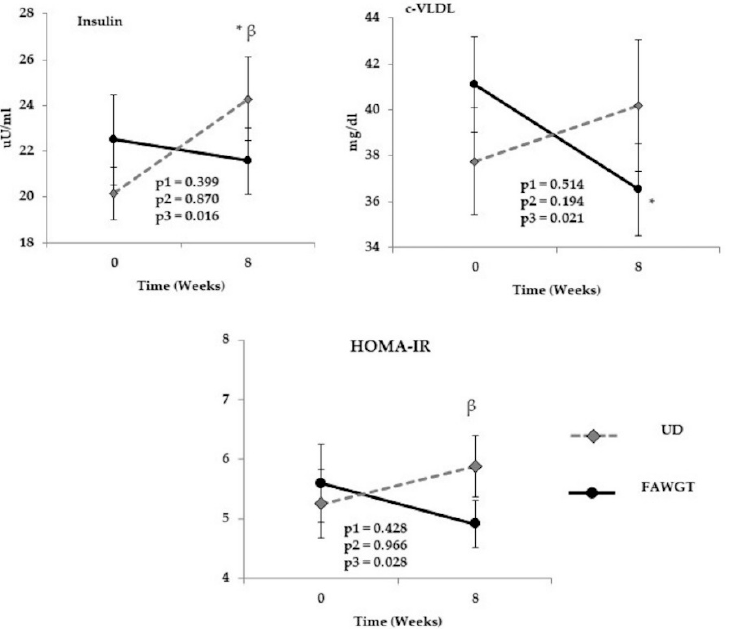
Figure 4. Chronic effect of the intake of a diet based on fruit, avocado, whole grains, and trout after 8 weeks of intervention. Values are shown as mean ± S.E.M, and the analysis corresponds to an ANOVA of repeated measurements, where p1 = diet influence; p2 = time, kinetics after the intervention period in fasting state; and p3 = the interaction of the two factors (diet vs. time). * p < 0.05 after 8 weeks of intervention compared to baseline. β = p < 0.05 FAWGT vs. UD. HOMA-IR: Homeostatic Model Assessment for Insulin Resistance; FAWGT: diet based on fruit, avocado, whole grains, and trout; UD: Usual diet.